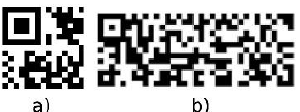
Figure 2. Other types of a QR Code: ( a ) Micro QR code, ( b ) iQR code.